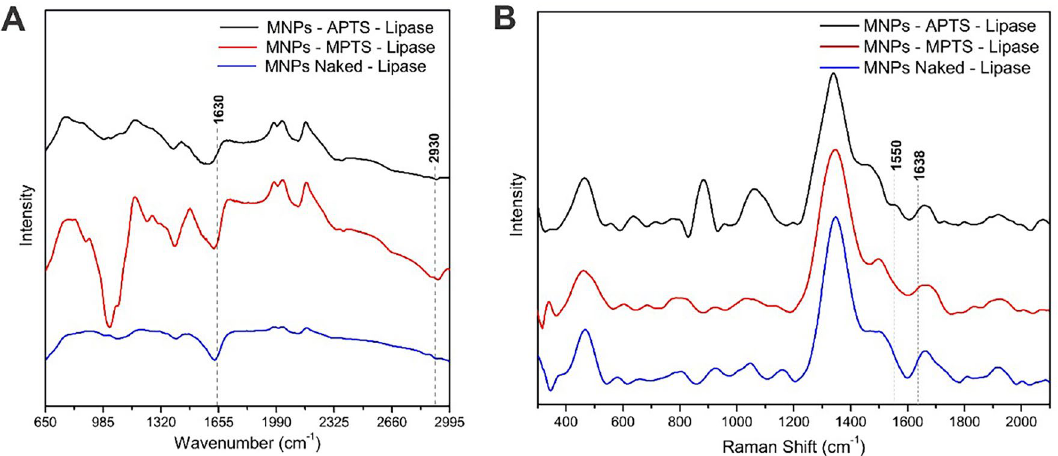
Figure 3. FTIR ( A ) and Raman ( B ) spectra of lipase-conjugated Fe 3 O 4 MNPs.